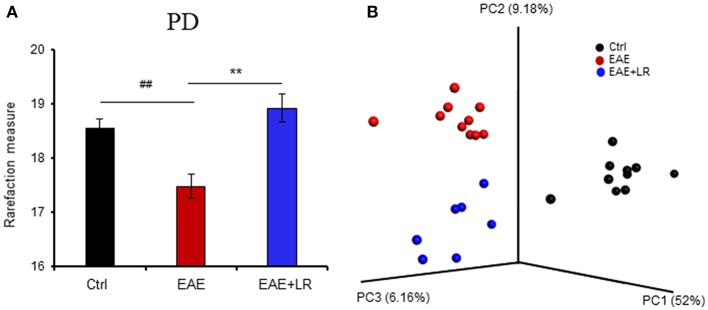
L. reuteri treatment modulates the diversity of the gut microbiota. (A) Gut microbial Phylogenetic Diversity (PD) whole tree analysis, comparing groups of Ctrl, EAE, and EAE+LR mice (n = 7–10 mice per group). (B) Unweighted UniFrac-based 3D PCoA analysis of gut microbiota of Ctrl, EAE, and EAE+LR mice (n = 7–10 mice per group). Data are presented as mean ± SEM. **p < 0.01. EAE+LR vs. EAE. ##p < 0.01. EAE vs. Ctrl.